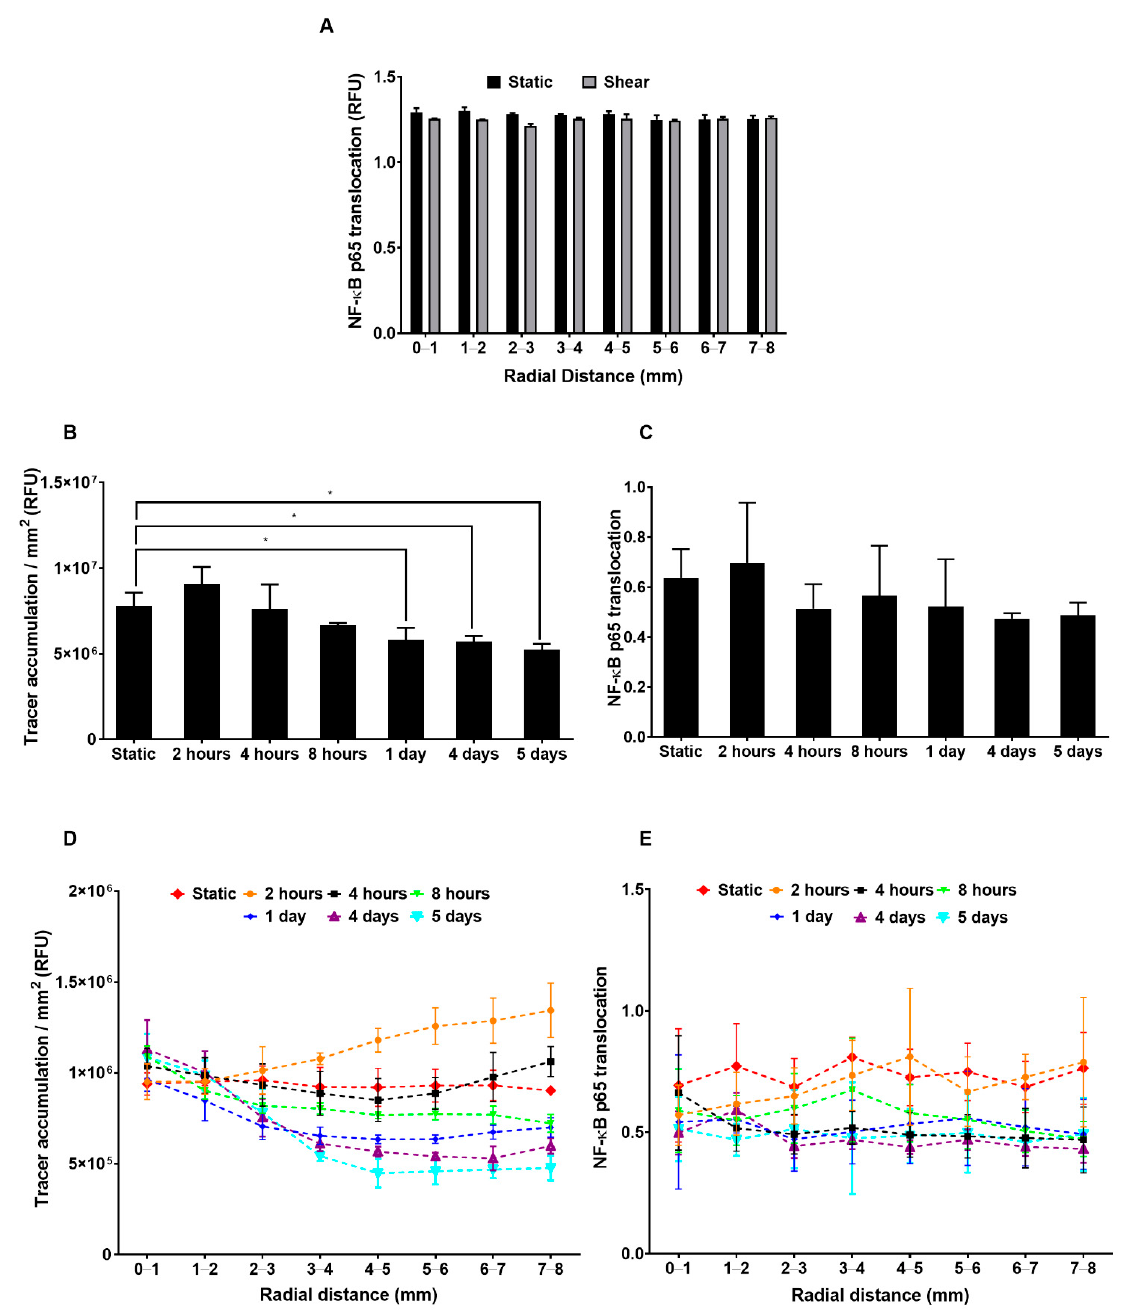
Figure 6. ( A ) NF- κ B p65 translocation as a function of radial distance from the centre of the well at 7 days of shear or static culture. ( B ) FITC-avidin accumulation and ( C ) NF- κ B p65 translocation averaged across the entire well after different durations of shear. ( D ) FITC-avidin accumulationd© ( E ) NF- κ B p65 translocation as a function of radial distance from the centre of the well after different durations of shear. Mean ± SEM, n = 3